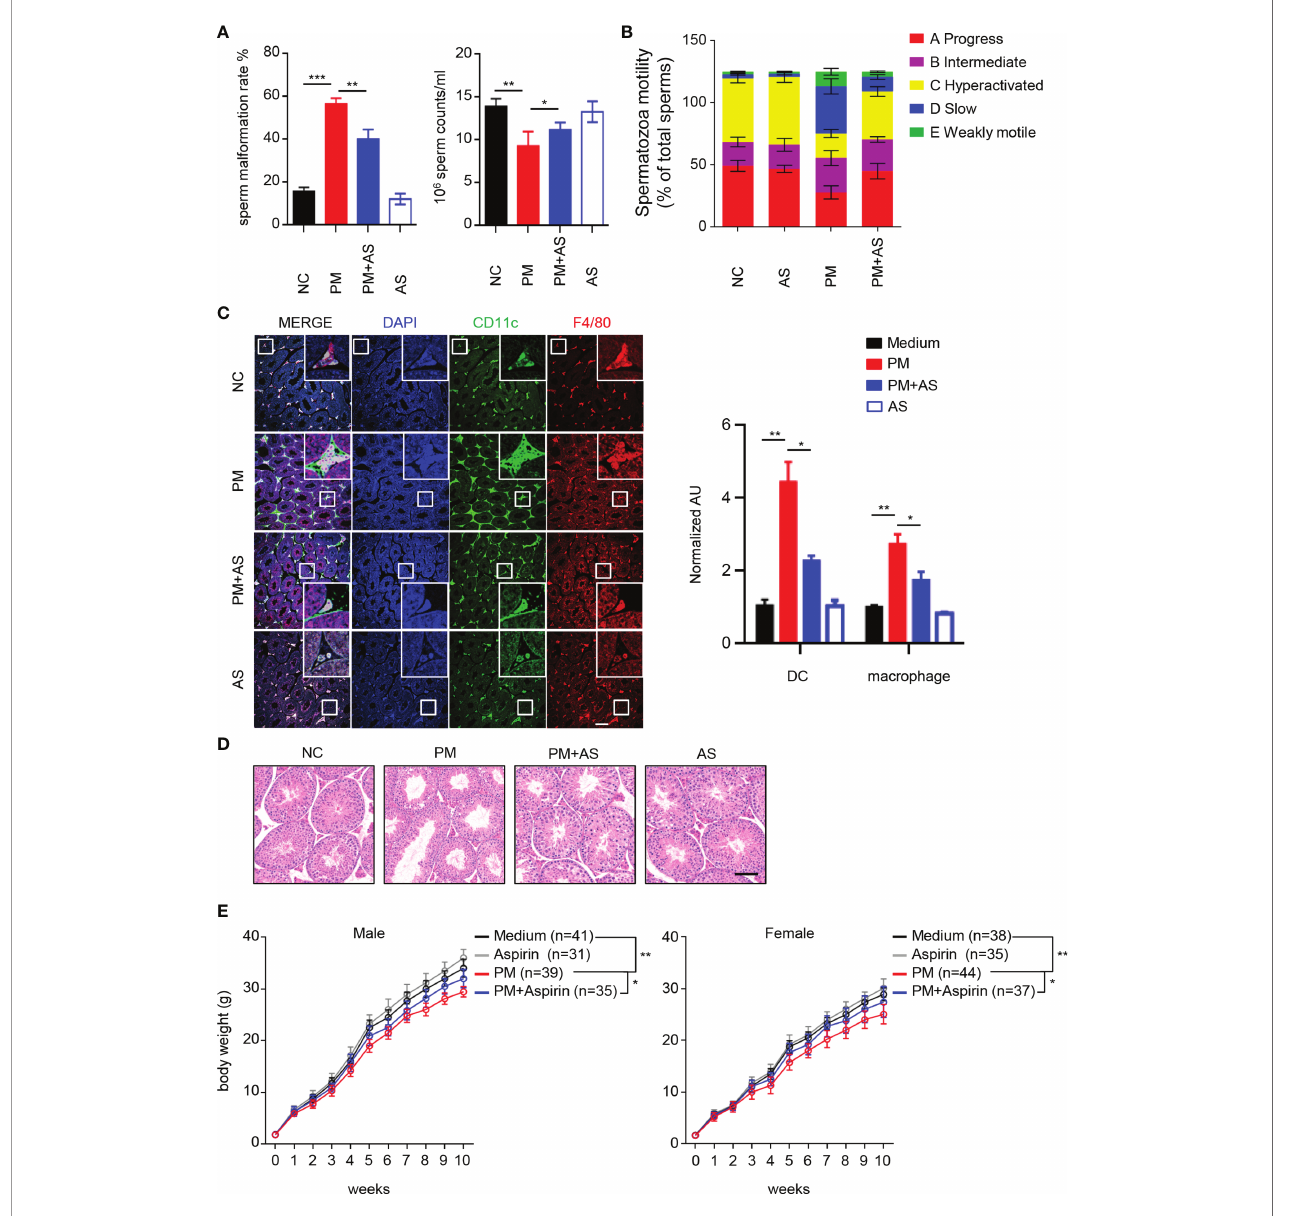
FIGURE 4 | Aspirin alleviates PM-induced orchitis in mice and restores the growth of offspring. (A) Quantitative analysis of sperm malformation rate and sperm counts of mice (n = 6) after 7 days PM exposure with or without intragastrically administration of aspirin. In (A – E) : NC, PBS; PM, 400 m g/kg PM; AS, aspirin 20 mg/ kg only; PM+AS, 400 m g/kg PM + 20 mg/kg aspirin. (B) Quantitative analysis of spermatozoa motility in mice after 7 days of PM exposure with or without aspirin administration. (C) Confocal immuno fl uorescence analysis of dendritic cells and macrophages in cryosections of mouse testes after 7 days of PM exposure with or without aspirin administration. Scale bars: 50 m m. (D) H&E staining evaluation of the empty area of seminiferous tubules in the testis of mice after 7 days PM exposure with or without aspirin administration. (E) Body weights of offspring of PM-exposed male mice. All mice were fed separately at 3 weeks of age and weighted weekly for 10 weeks. Data represent two independent experiments and are presented as mean ± SEM. * P < 0.05; ** P < 0.01; *** P <